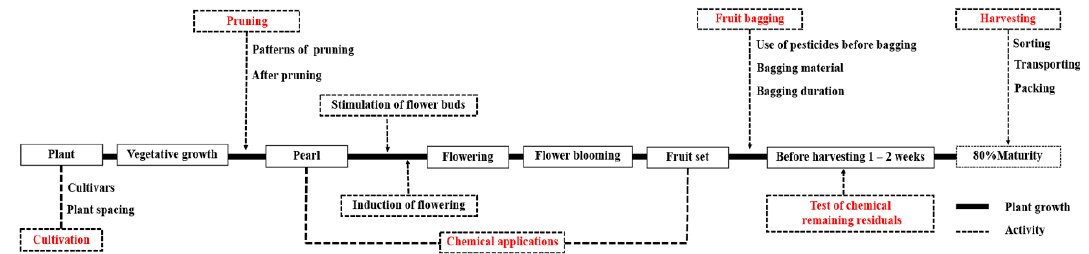
Figure 3. ‘Nam Dok Mai’ mango production process followed by growers. The risk points of Figure 3 . ‘Nam Dok Mai’ mango production process followed by growers . The risk points of post - post-harvest disease infection are indicated in dash line boxes with red letters. harvest disease infection are indicated in dash line boxes with red letters .